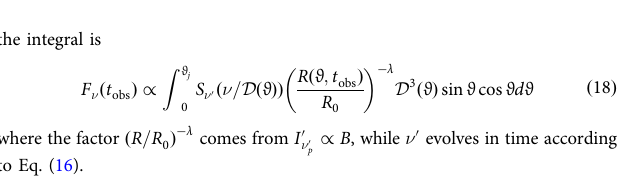
The large values of ( Δ AIC ) ∣ spectrum = (AIC HLE − AIC AC ) ∣ spectrum indicate that, regardless of the assumed spectral shape, the HLE from ef fi ciently cooled particles is strongly disfavored with respect to the adiabatic cooling